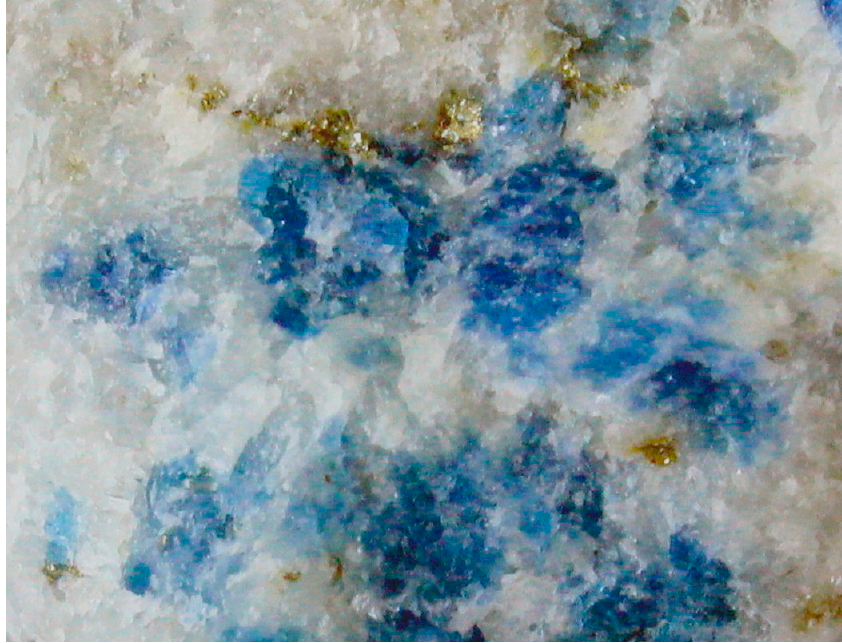
Figure 3. Light blue haüyne (the MD sample) in calciphyre, in association with pyrite (yellow, with metallic luster). Field of view width: 15 mm. Photographer: Sergey V. Lipko.